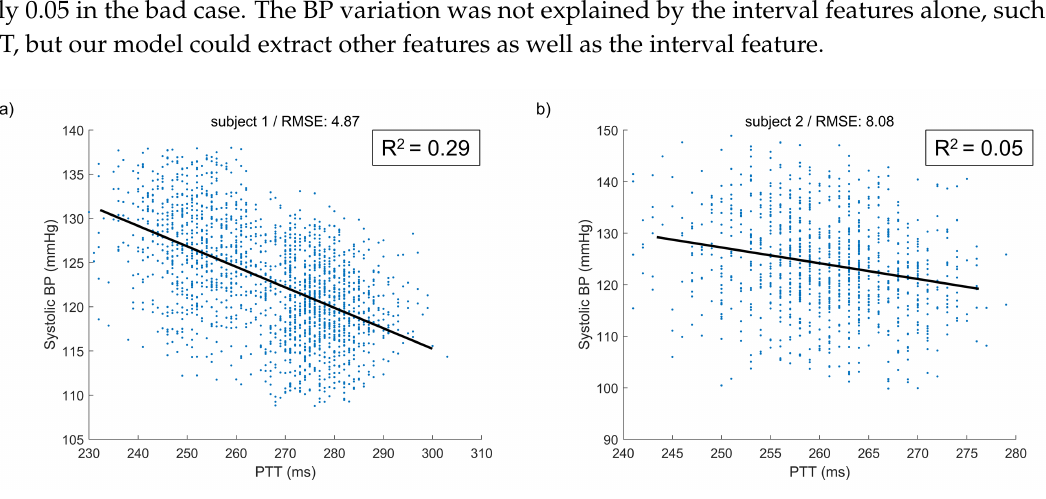
Figure 14. Scatter plots between PTT and Systolic BP of ( a ) good case and ( b ) bad case. The black line indicates a fitting